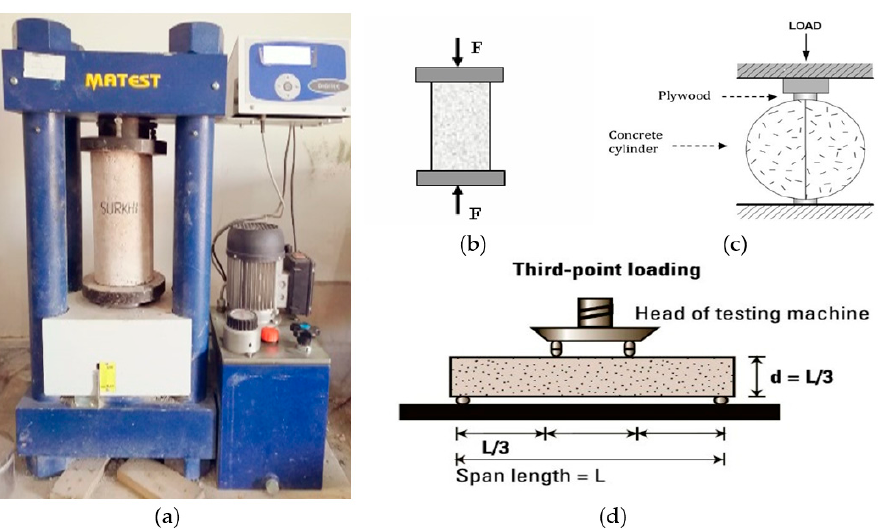
Figure 4. ( a ) Testing machine, ( b ) compressive strength test mechanism, ( c ) split tensile test mech- anism, and ( d ) flexural strength test mechanism. nism, and ( d ) flexural strength test